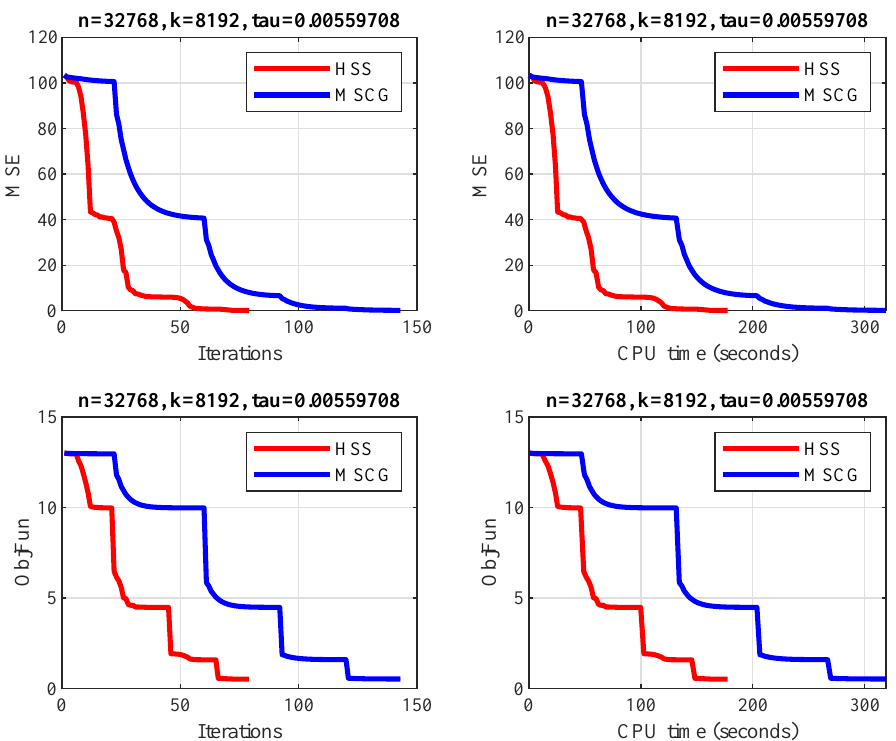
Figure 5. Comparison result of HSS and MSCG. The x -axis represents the number of Iterations top left and bottom left and CPU time in seconds top right and bottom right. The y -axis represents the mean of squared error (MSE) top left and top right and the objective function values bottom left and bottom